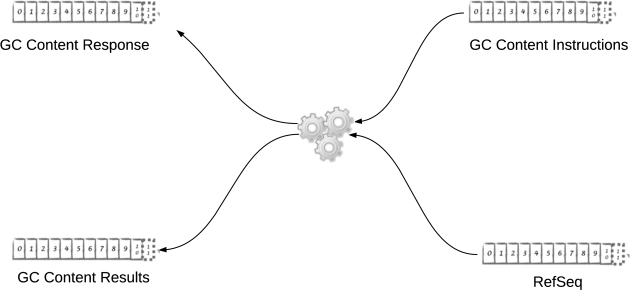
GC content agent.